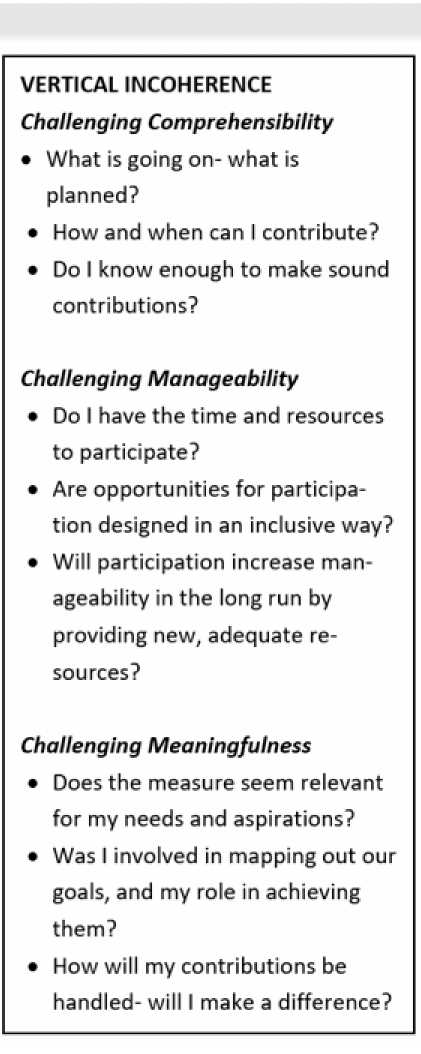
Figure 1. Vertical